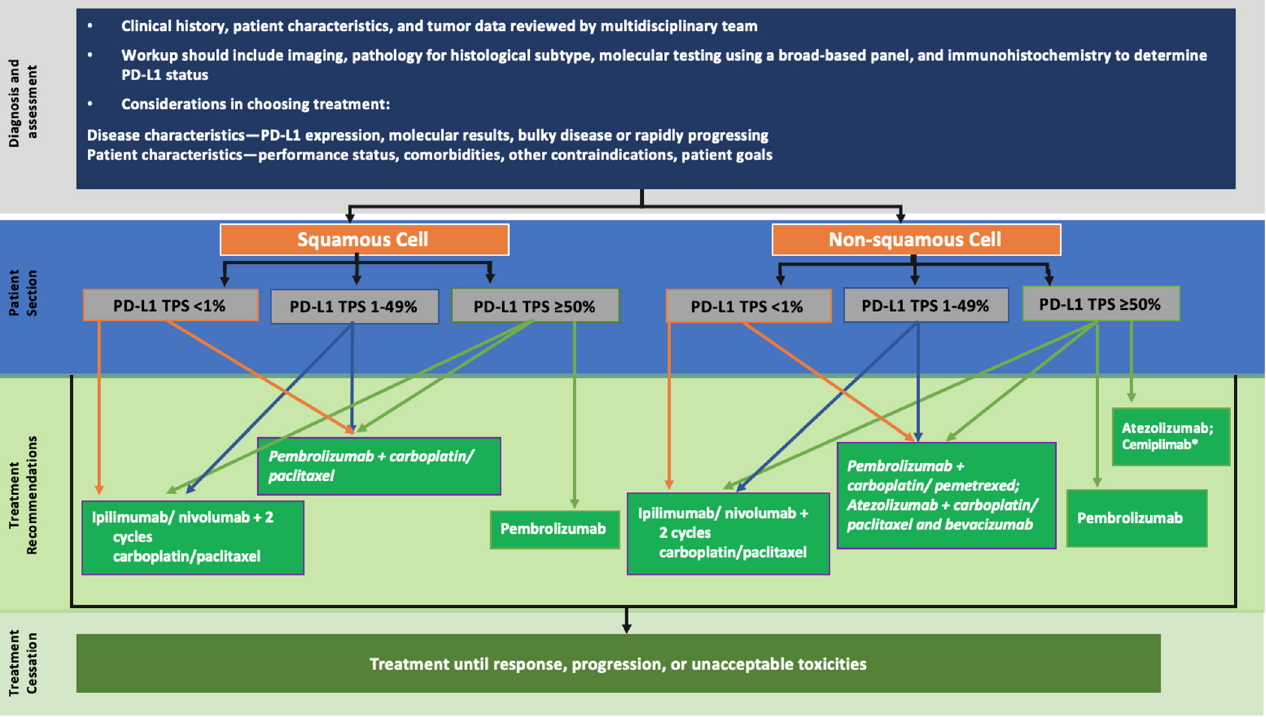
Figure 3. Potential treatment paradigm in the European Union for NSCLC without actionable mutations in front line. Adapted from [71,73]. * European authorization expected shortly.